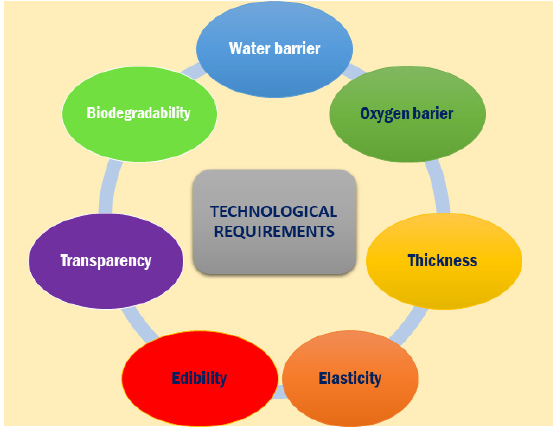
Figure 6. Technological requirements of biopolymers derived from fish by-products for food pack- aging.